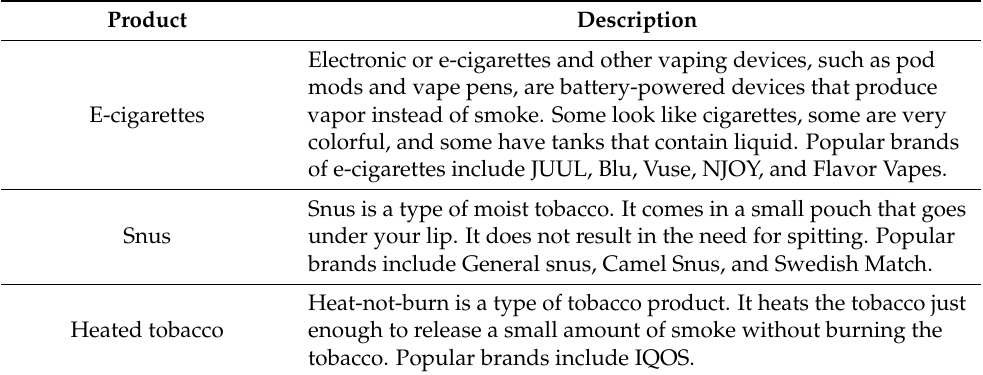
Table 2. Tobacco products currently or with the potential to receive modified risk tobacco products (MRTP) authorization and the product descriptions. Product